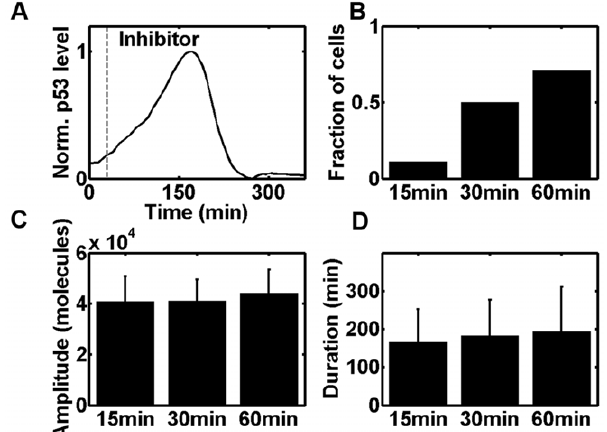
Figure 7. Excitability of p53 pulses. (A) A sample trajectory is shown where inhibitor was added after 30 min (dashed line: 30 min, set k auto and k DSB =0 after inhibitor is added). (B) Fraction of cells showing a p53 pulse. (C and D) The amplitude of p53 pulses (C) and their duration (D) were unaltered (error bars indicate the standard deviation).